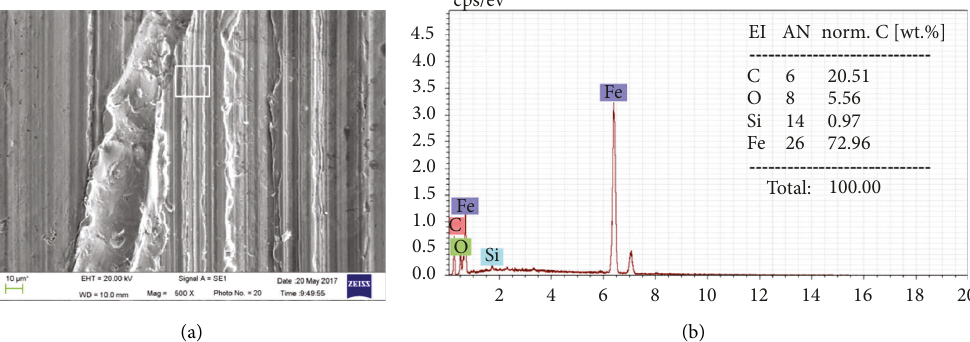
Figure 9: (a) A SEM micrograph of the wear scar lubricated with nanofluid under 300 (N) and (b) an EDS spectrum of the marked area of (a).